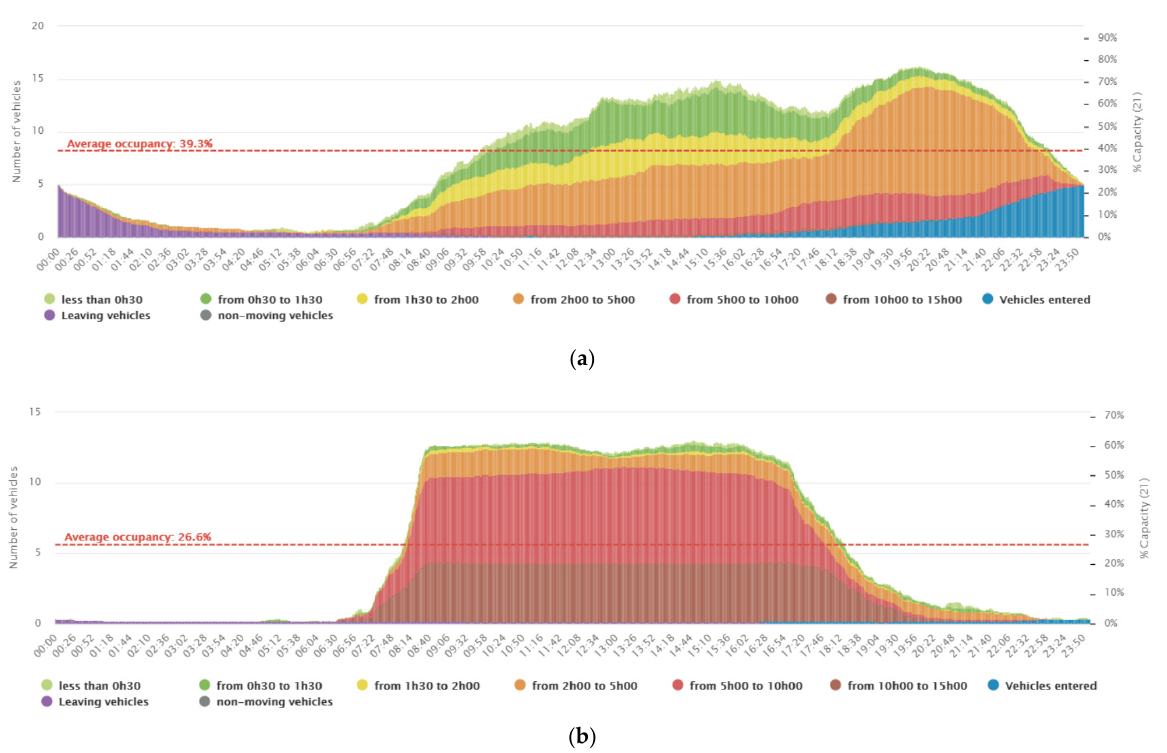
Figure 3. Average occupancy of the selected Office and Cultural site (Bd. Du théâtre, Geneve): ( a ) before the confinement period (between 5 January and 5 February 2020), and ( b ) during the confinement period (between 1 and 30 April 2020).